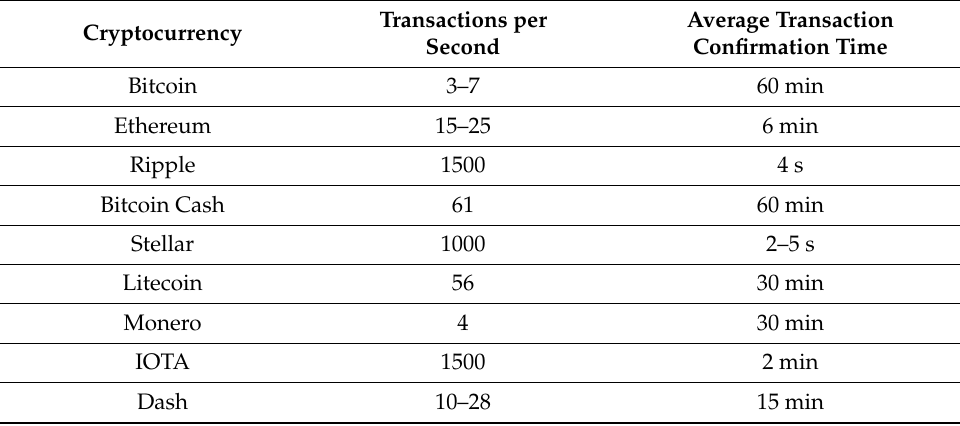
Table 2. The speed of various cryptocurrencies’ transactions